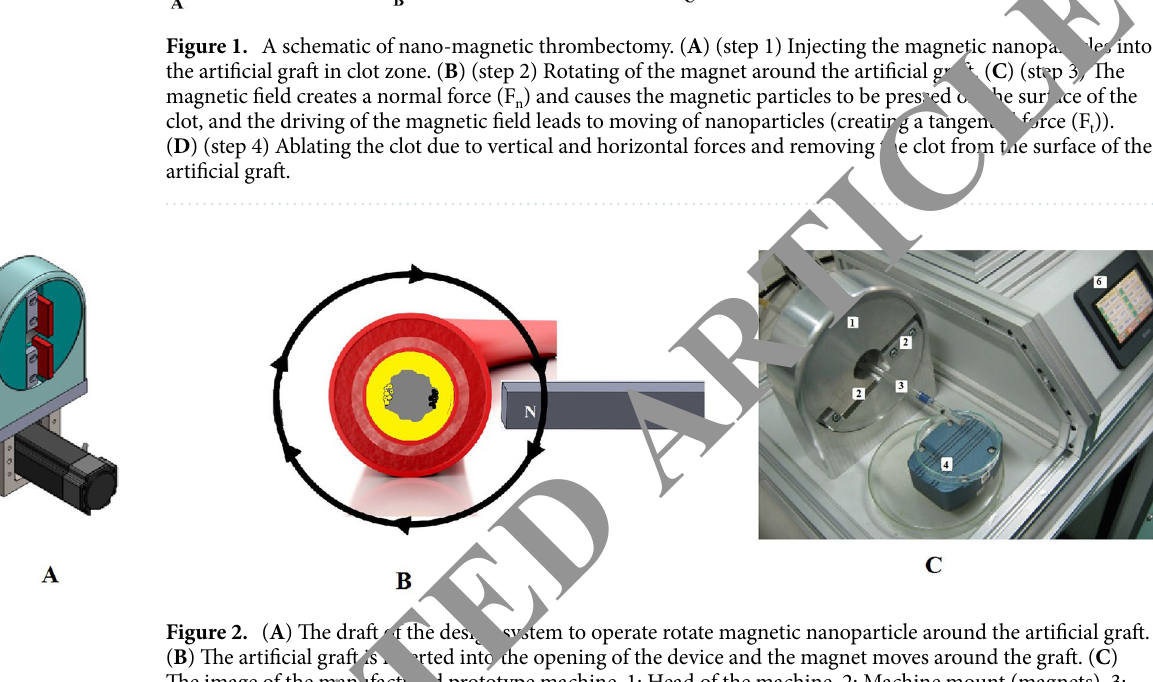
Figure 2. ( A ) The draft of the design system to operate rotate magnetic nanoparticle around the artificial graft. ( B ) The artificial graft is inserted into the opening of the device and the magnet moves around the graft. ( C ) The image of the manufactured prototype machine. 1: Head of the machine. 2: Machine mount (magnets). 3: Arterial vessel. 4: Output fluid collection. 5: Fixtures for vessel placement 6: HMI and PLC.